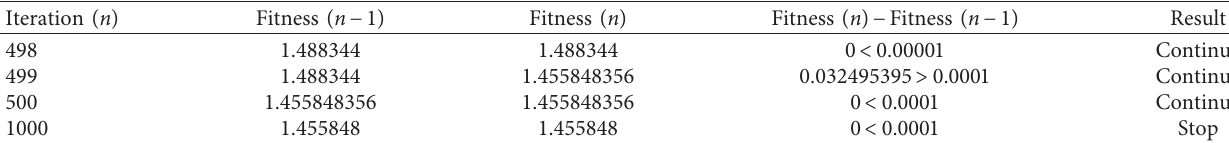
Figure 3: The convergence curve of PSO and Table 4: Precision level and calculation termination of PSO at the 1000th iteration.